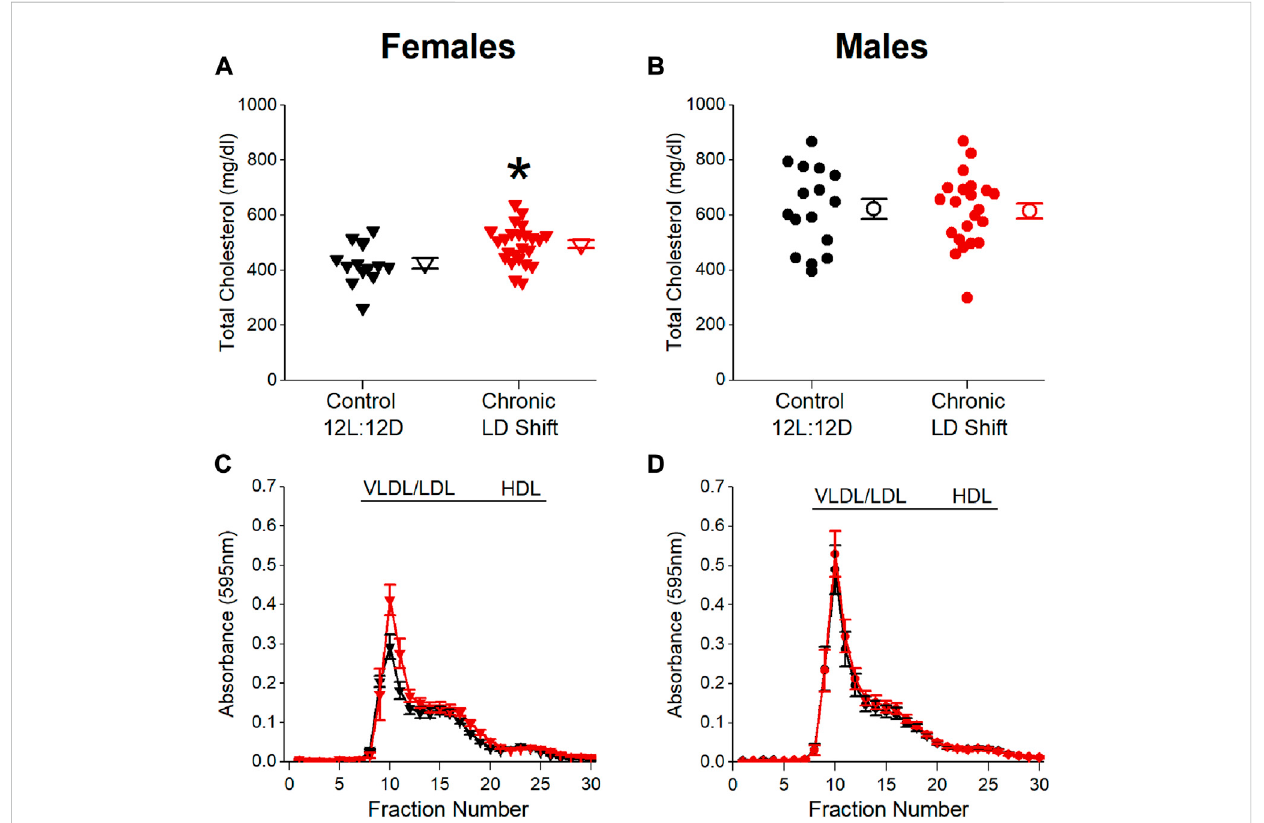
FIGURE 2 Chronic LD shifts increased dyslipidemia in female, but not male, ApoE − / − mice. Total serum cholesterol concentrations (A,B) and distribution of lipoprotein-cholesterol (c, d; FPLC was performed in n = 4 – 5/group) in female (A,C) and male (B,D) ApoE − / − mice housed in control 12L:12D (black symbols) or chronic LD shifts (red symbols). (A,B) : individual mice are closed symbols and open symbols are mean ± SEM. * p =